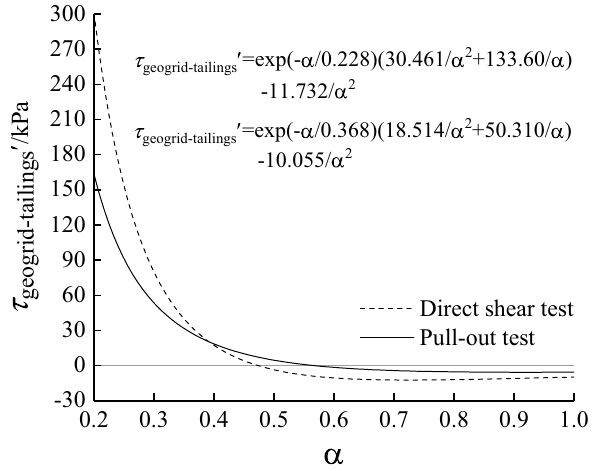
Figure 6. τ ′ geogrid-tailings − α curve under different normal stress and different test conditions.